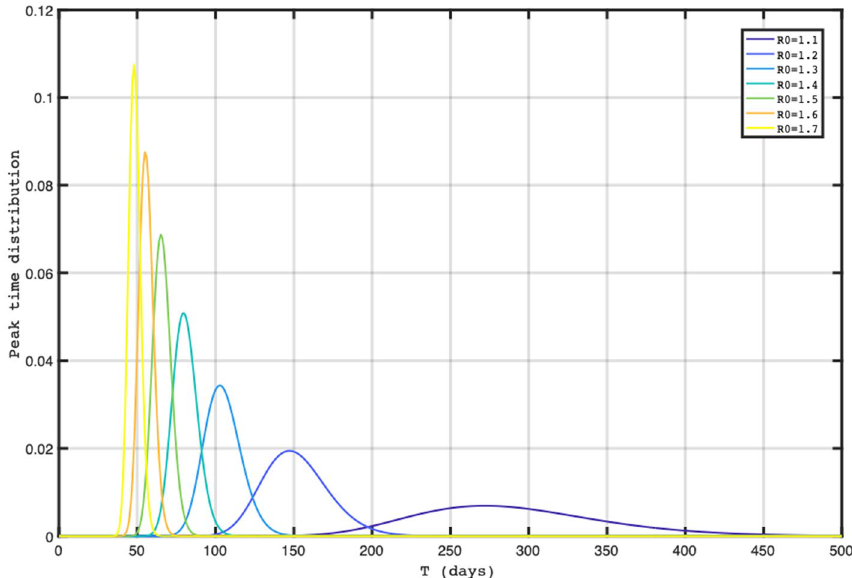
Figure 1. It illustrates the distribution of epidemic peaks at various intervals from the start of an outbreak, based on a theoretical model that considers R 0 values ranging from 1.1 to 1.7. The figure displays how the peak of the epidemic may vary depending on the number of days since the beginning of the outbreak and the corresponding R 0 value.